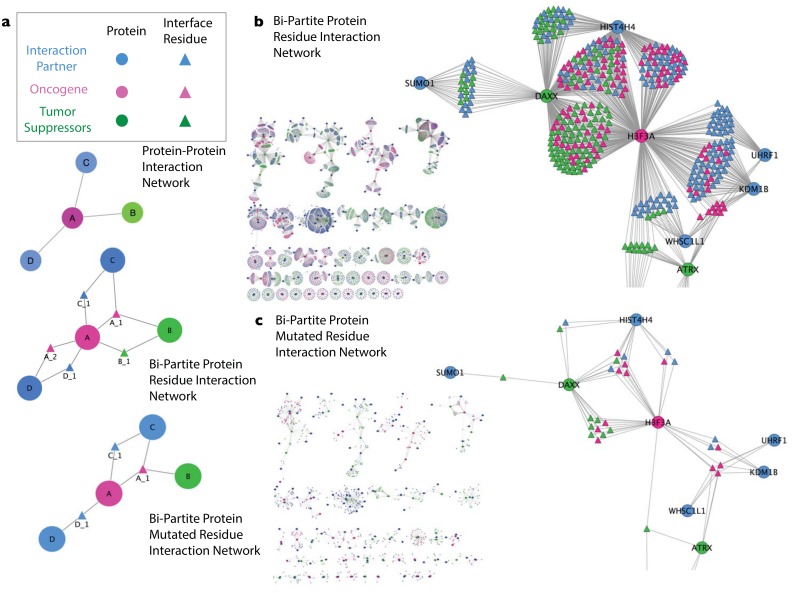
A bipartite protein-residue interaction network constructed for cancer genes and their interaction partners.Edges involved in self-interaction are not shown. a) An example of a network describing how proteins, interface residues and mutations are represented in the bipartite network model. In a protein-protein interaction network, the nodes representing proteins A–D are directly connected to one another. In our bi-partite protein residue interaction network, interface residues are displayed between proteins. For example, residue 1 on protein A (A_1) is involved in the protein-protein interface between A and B along with A and C. Residues mutated in cancer are shown in the bi-partite protein mutated residue interaction network. For example, A_1 is mutated in at least one cancer in one patient whereas residue B_1 –present above but absent here—is not. b) A bipartite network showing cancer genes and their immediate interactors. c) A bipartite network displaying only residues that were mutated in one or more tumors. The circled interface residues interact with multiple proteins.